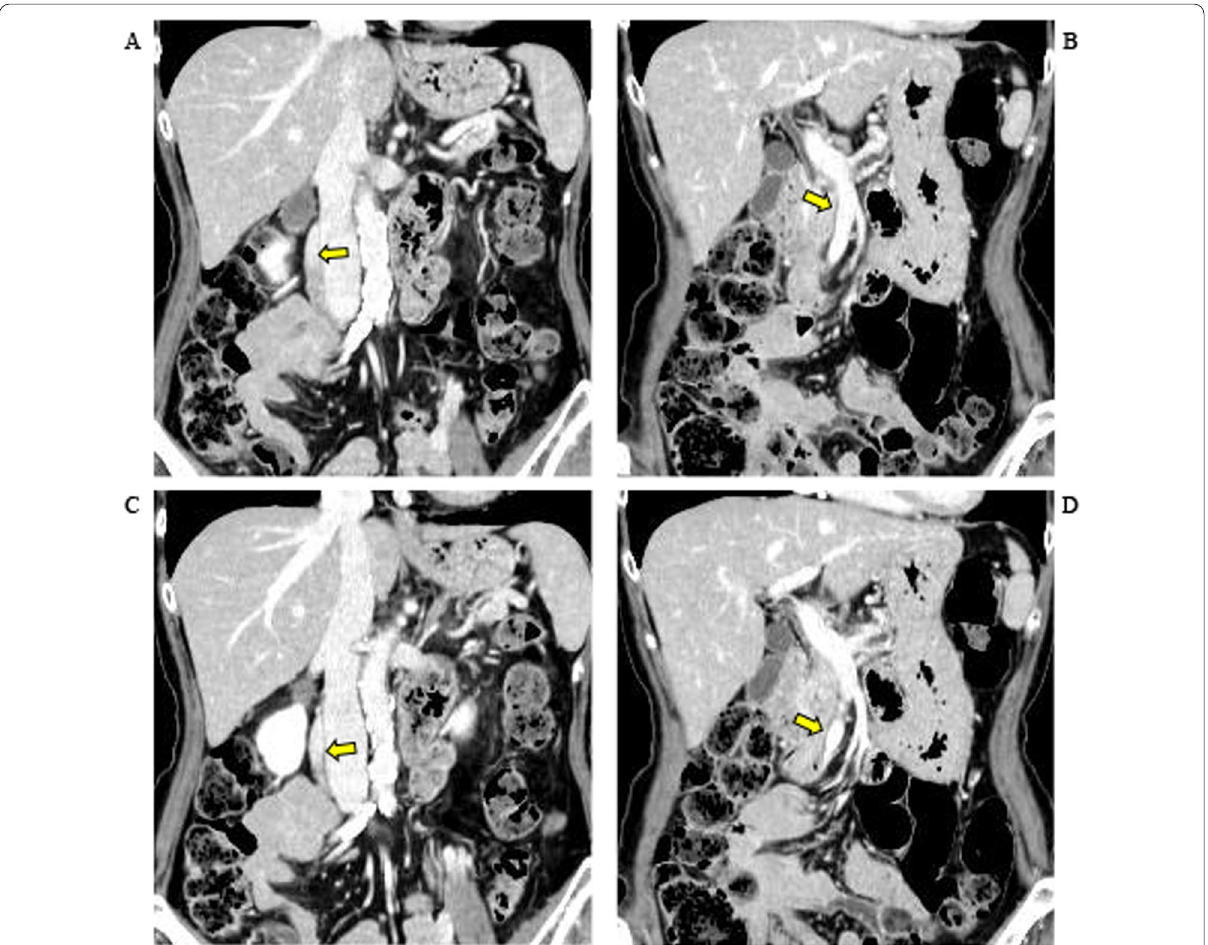
Fig. 2 Computed tomographic appearances of the right ovarian vein ( A , C ) and the superior mesenteric vein invaded by the tumor ( B , D ). The right ovarian vein shows dilation to a diameter of about 10 mm, approximating the dimensions of the portion of the superior mesenteric vein to be